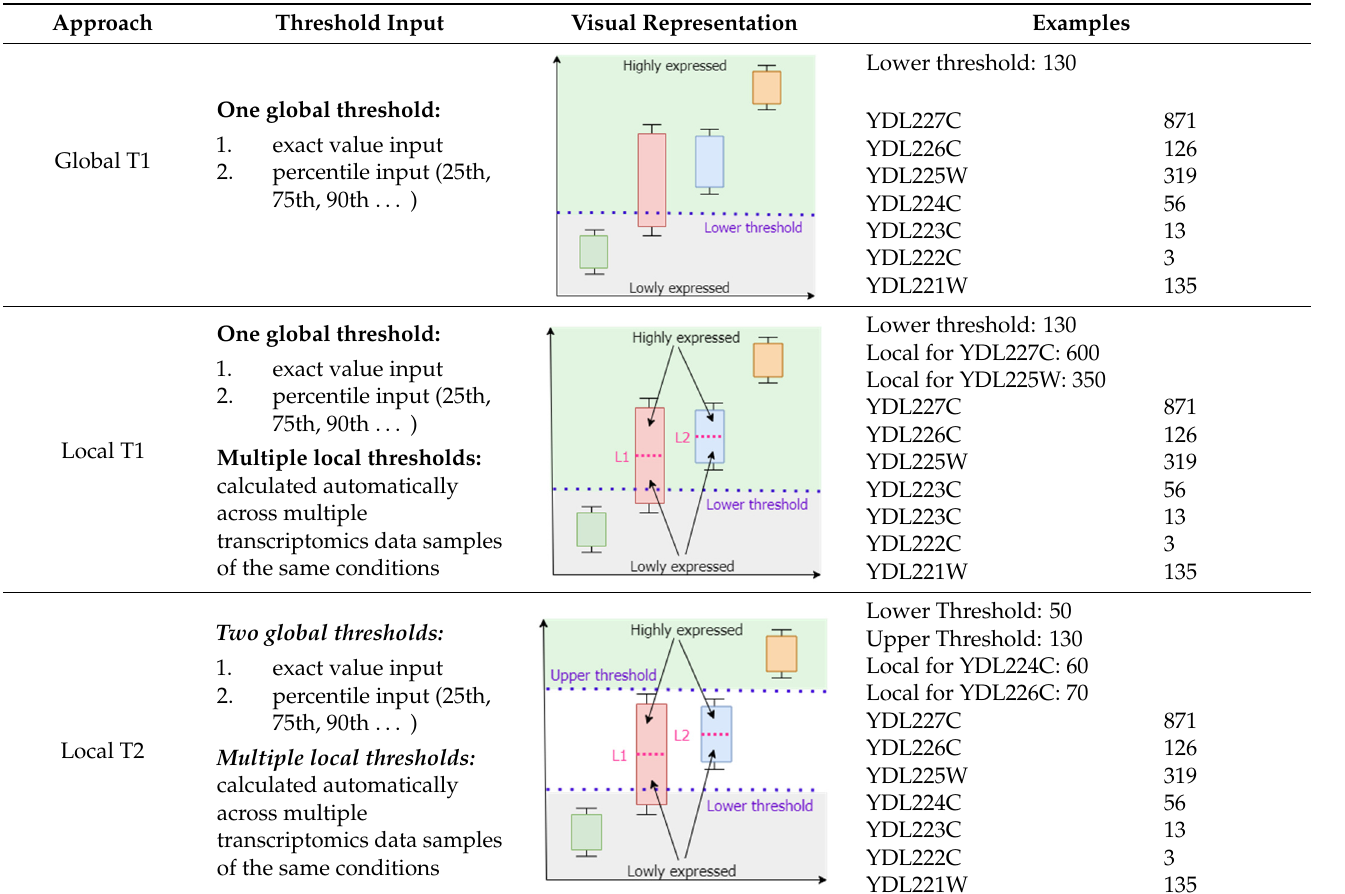
Table 1. Thresholding Options.